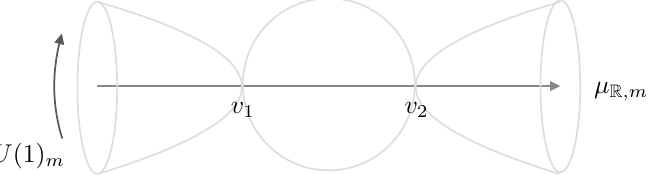
Figure 10. The slice (cid:22) C CP 1 exhibited as an S 1 -(cid:12)bration over R parametrized by ;m = 0 of T (cid:3) (cid:22) R ;m . The U(1) m (cid:13)avour symmetry rotates the (cid:12)bers with (cid:12)xed points at (cid:22) R ;m = corresponding to the vacua v 1 and v 2